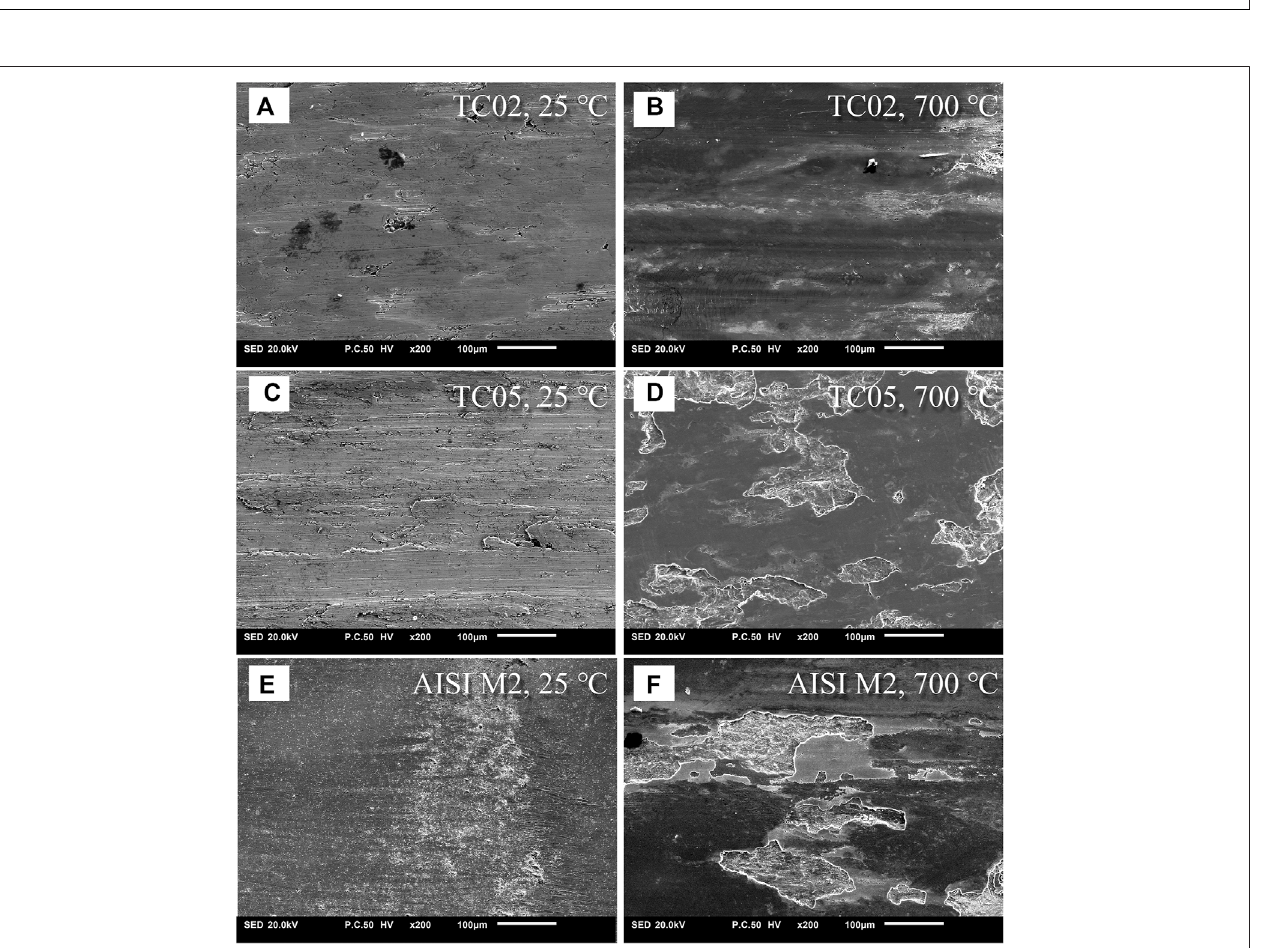
FIGURE 6 | SEI images of the worn surface of (A,C,E) alloys at room temperature and (B,D,F) at 700 ° C.